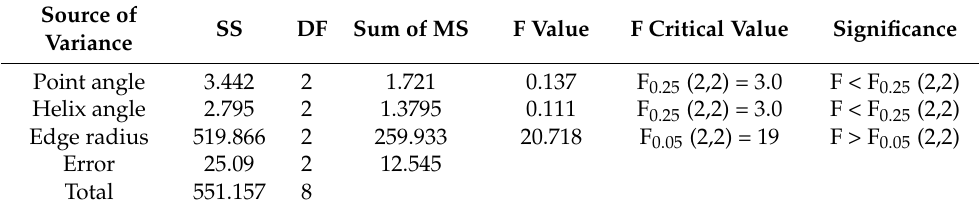
Table 5. Analysis of variance (ANOVA) of bit parameters influence on drilling force. Source of Variance